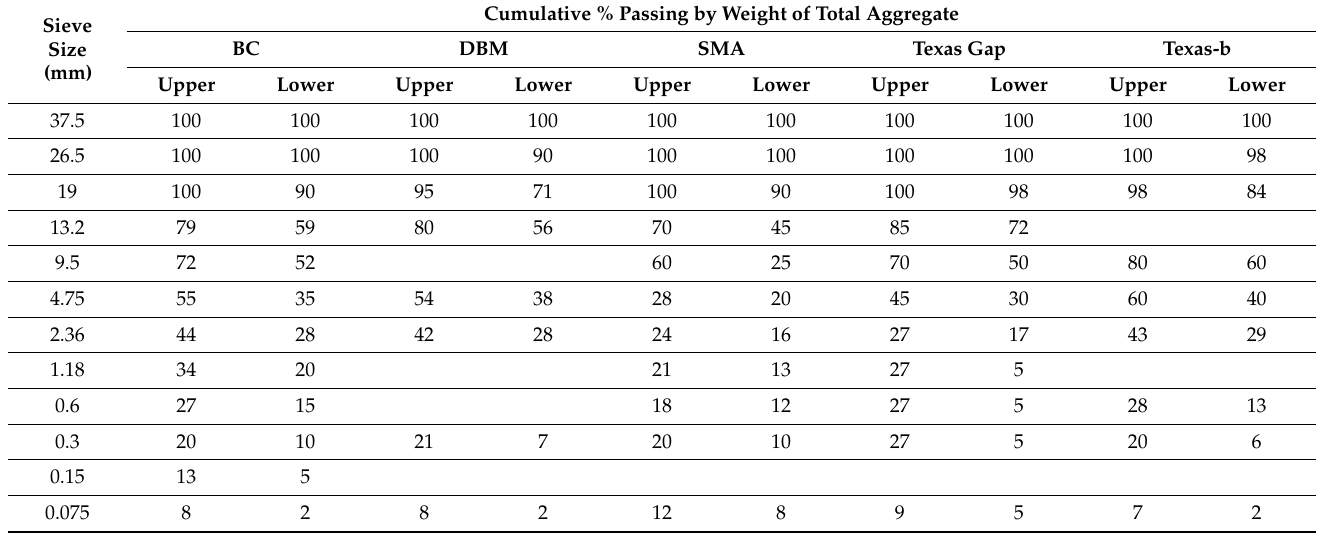
Table 2. Aggregate gradations in the present